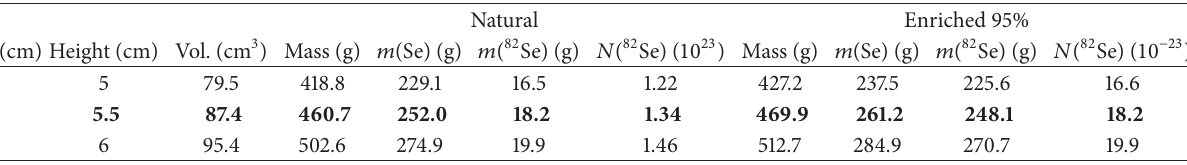
Table 1: Mass balance of ZnSe crystals grown from natural and enriched raw material. The baseline choice for LUCIFER is highlighted in bold. Natural Enriched 95%